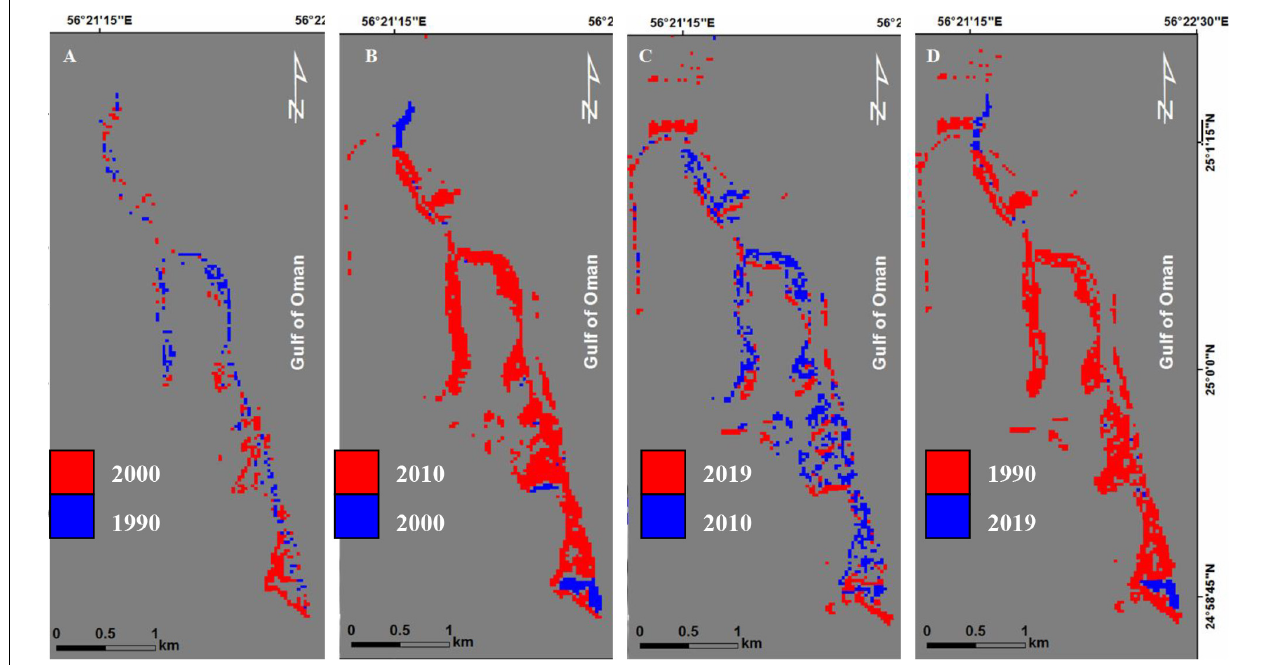
FIGURE 12 | Mangrove pattern change between 1990 and 2000 (A) , 2000 (B) , 2010–2019 (C) , and 1990–2019 (D) for Khor Kalba natural reserve. Red color highlights changes in